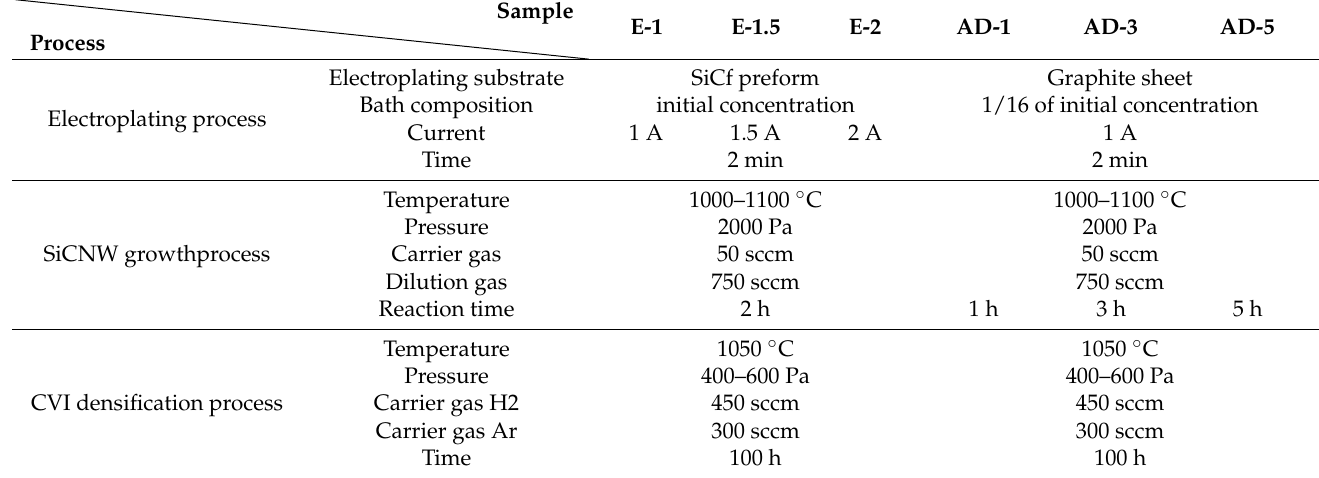
Table 1. Parameters for the in-situ growth of SiCNWs and CVI